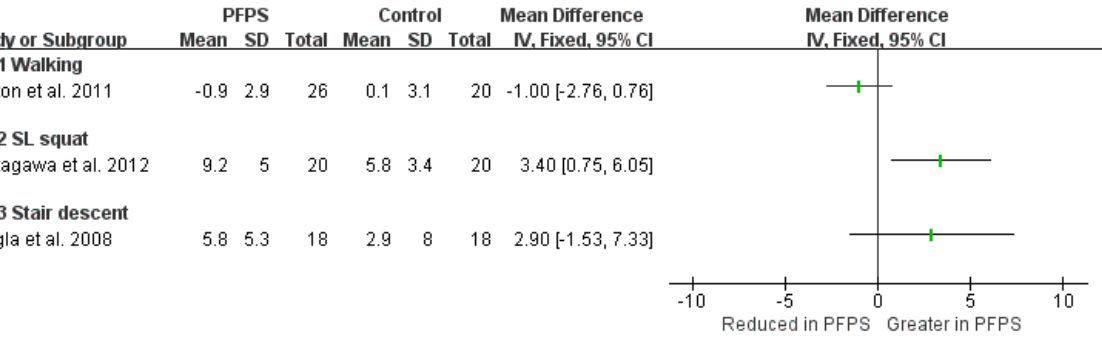
Figure 5. Knee flexion angle among the various functional activities [19,22].